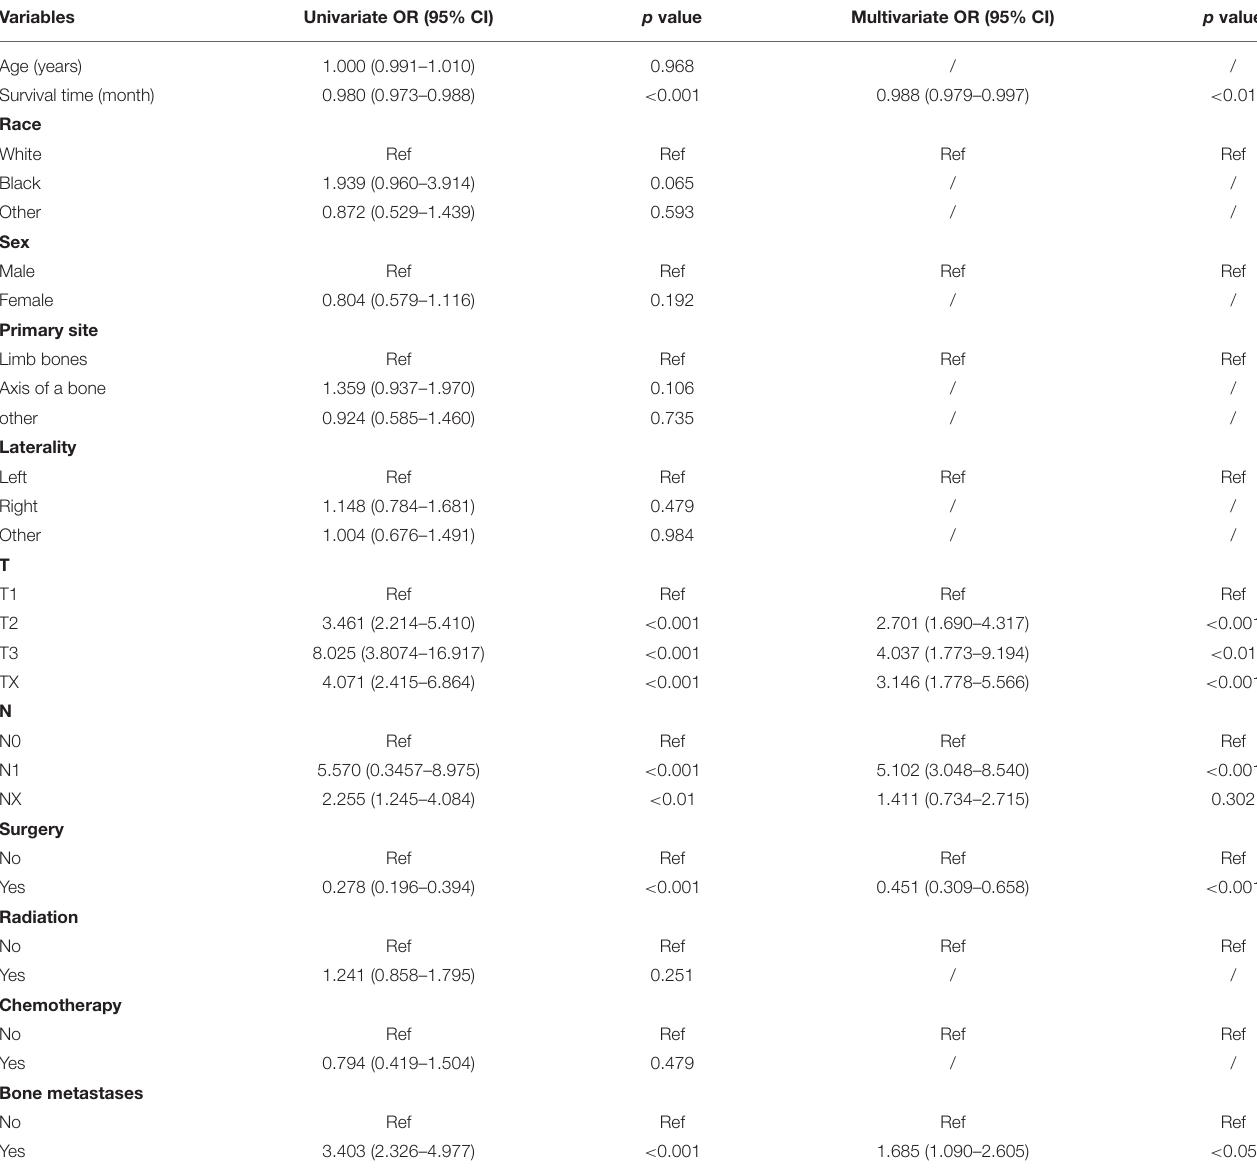
TABLE 3 | Univariate and multifactorial logistic regression analysis of risk factors for lung metastasis in patients with Ewing sarcoma.